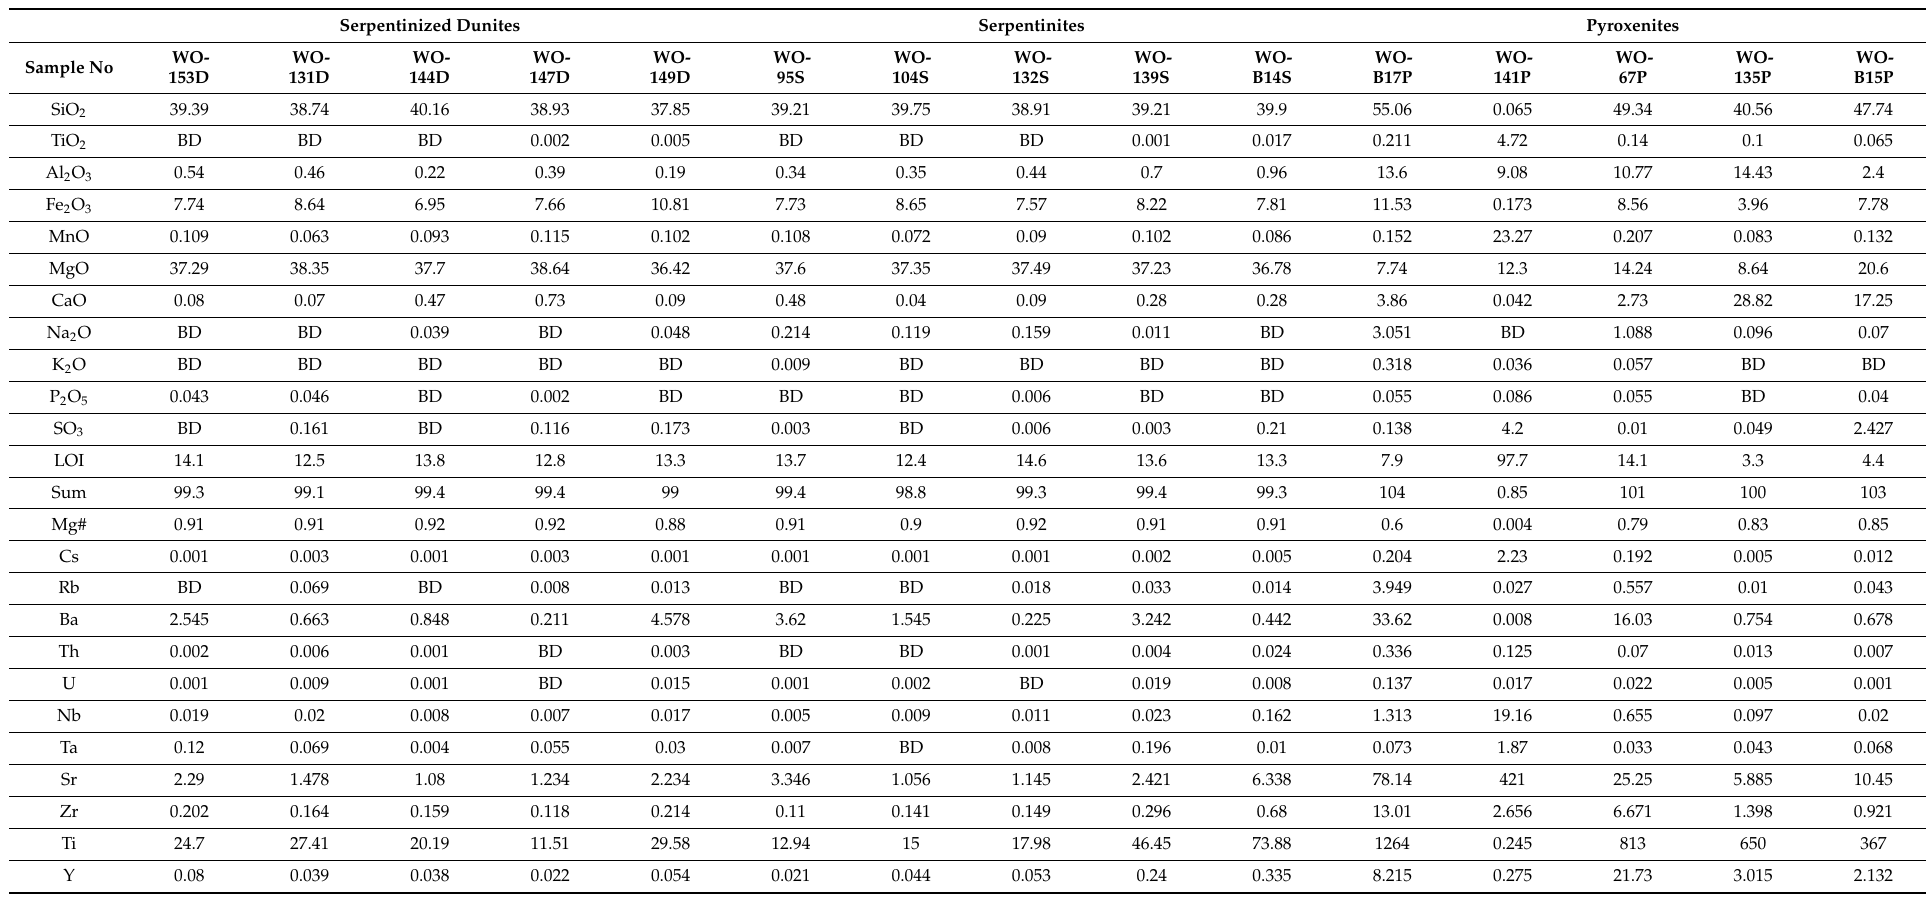
Table 1. Whole rock major elements (in weight %) and trace elements including rare earth elements (in ppm) of the studied ultramafic rocks from part of the Waziristan ophiolite complex (WOC). Mg# = (MgO/Molar mass MgO)/(MgO/Molar mass MgO) + (0.8995 × Fe 2 O 3 /molar mass of FeO). LOI: loss on ignition. BD: Below detection limit